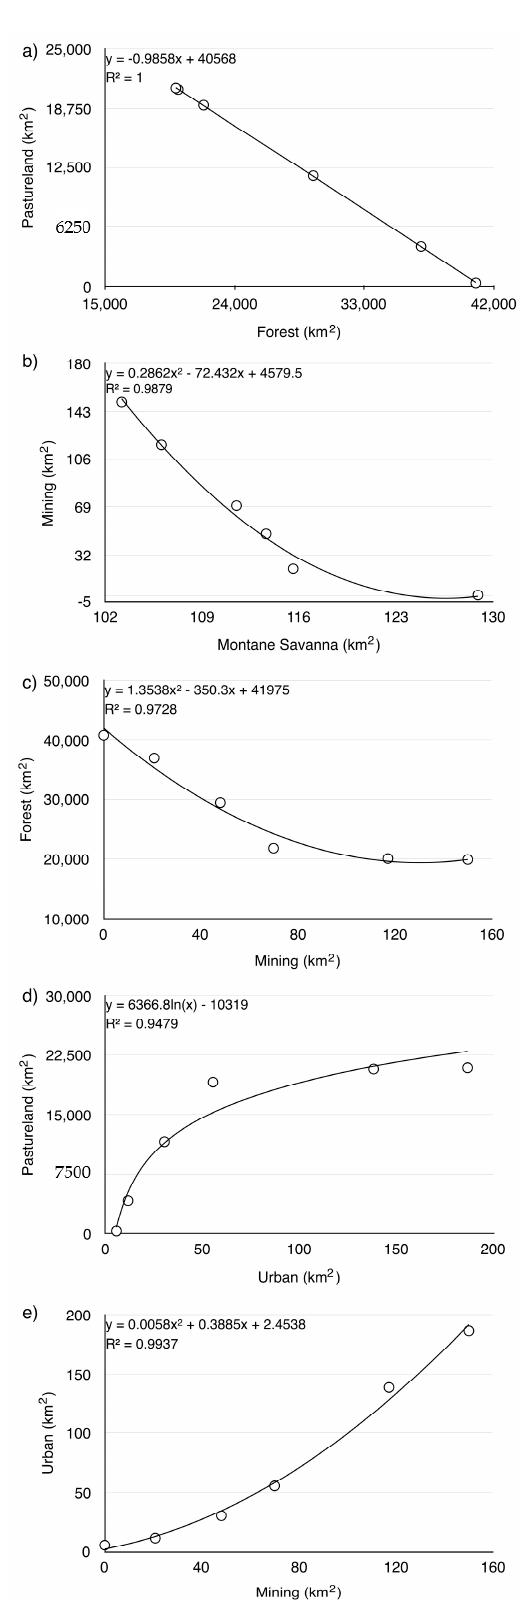
Figure 9. Correlations between the LCLU class areas from 1984 to 2013 based on the dataset in Table 4: ( a ) forests and pasturelands; ( b ) montane savannas and mining areas; ( c ) mining and urban areas; ( d ) pastureland and urban; and ( e ) urban and mining.